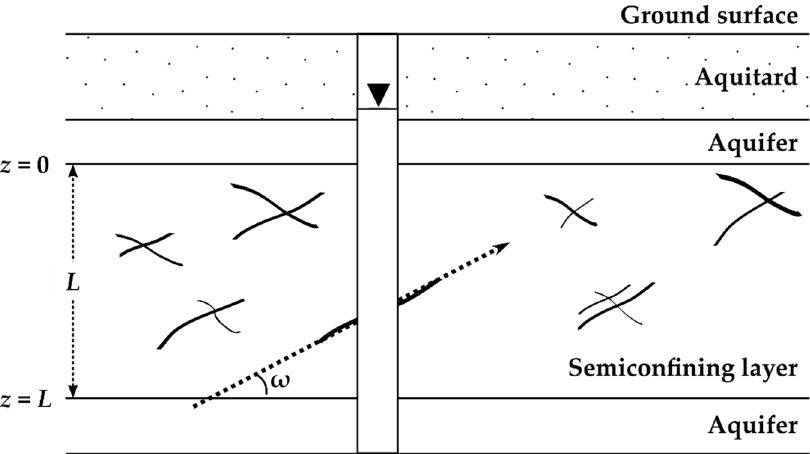
Figure 2. Conceptual model of groundwater flow in fractured media (modified after Ge [27]).